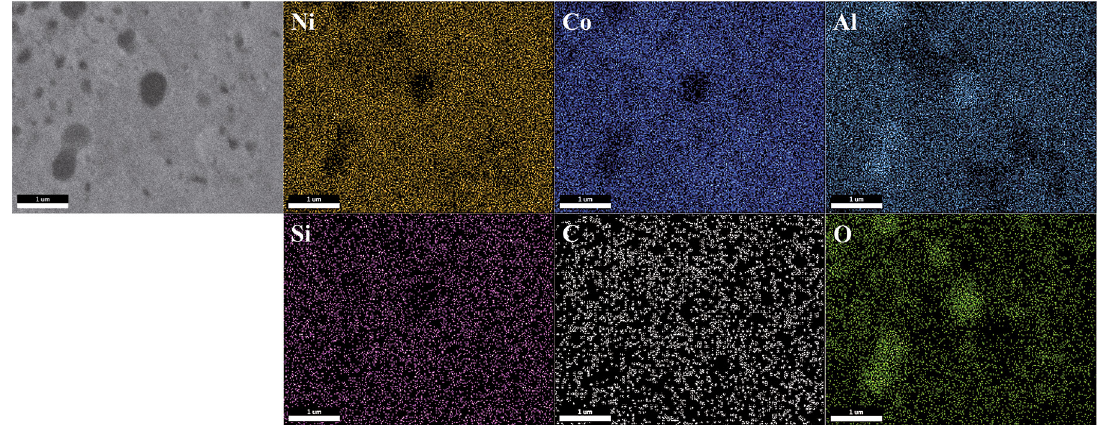
Figure 7: SEM–EDS mappings of 5% SiC reinforced AlCoNi sample after sintering.